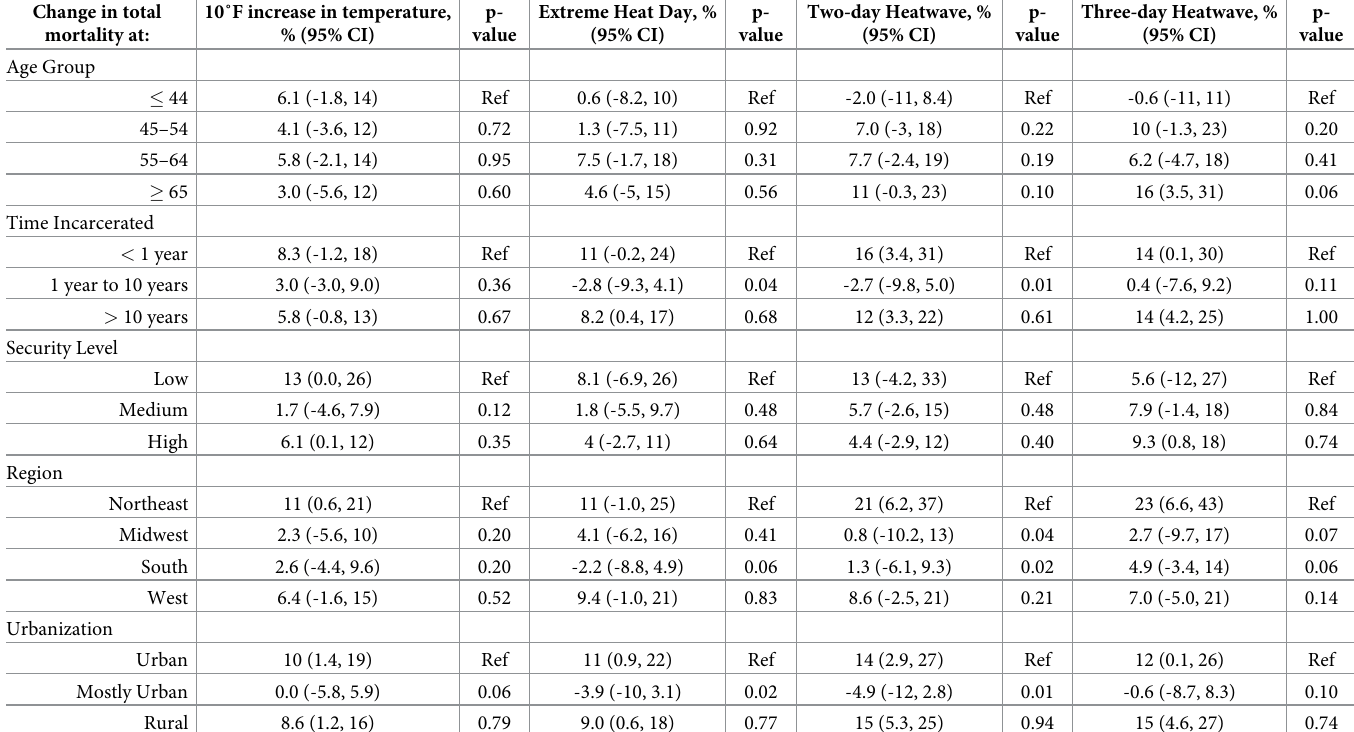
Table 3. Percent change in mortality with 95% confident intervals associated to temperatures in summer months using an interaction term for personal, facility, and regional characteristics in US prisons from 2001–2019 a,b,c,d . Change in total mortality